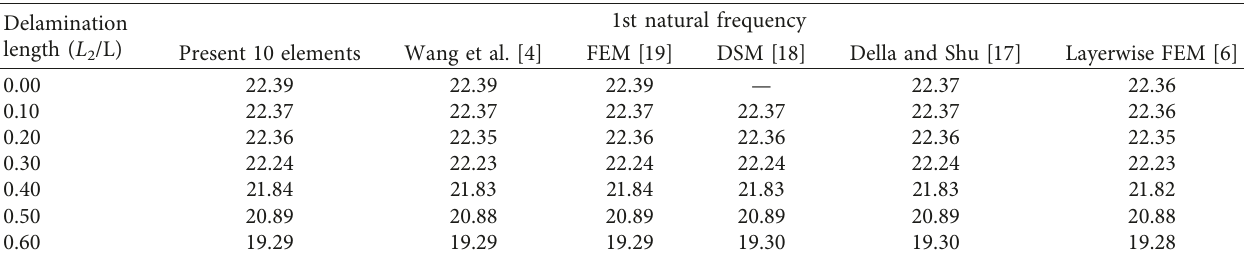
Table 1: The first nondimensional natural frequency ( λ 2 conditions.